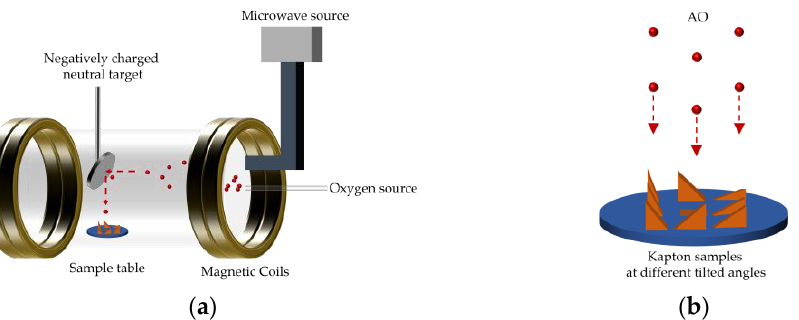
Figure 1. Schematic diagram of ground-based atomic oxygen experimental setup: ( a ) test device; ( b ) atomic oxygen erosion.